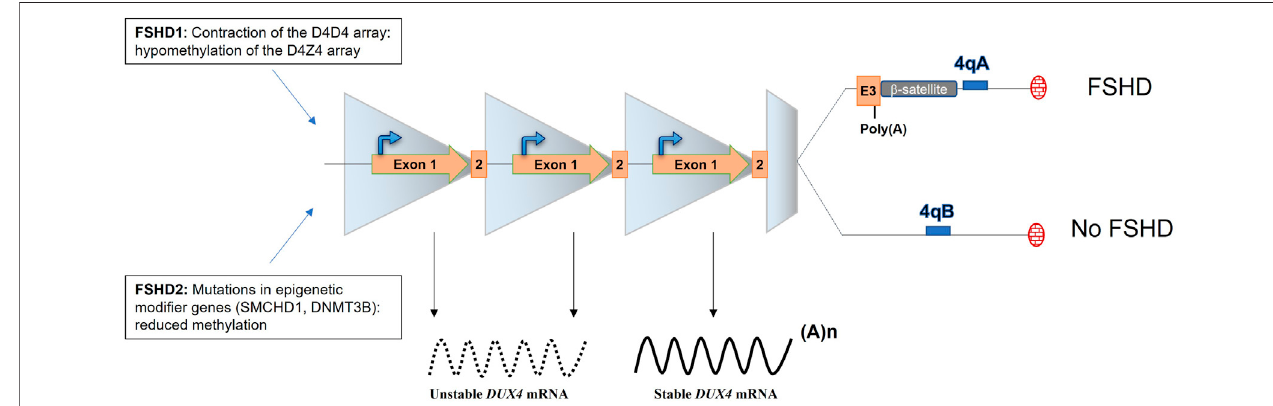
FIGURE 2 | The locus D4Z4 and molecular mechanisms leading of FSHD. The D4Z4 locus is composed of 11 – 100 repeats in healthy individuals and is highly methylated.FSHD1patientspresentacontraction oftheD4Z4array(1 – 10unitsleft)leadingtochromatinrelaxation.FSDH2patientspresentalsoachromatinrelaxation that ismediatedbymutations inepigenetic modi fi ergenes.FSHD occurs whenthe D4Z4array isrelaxed andDUX4 expressed. DUX4 expression isuniquelyassociated with the 4qA haplotype, which carries the DUX4 p(A).